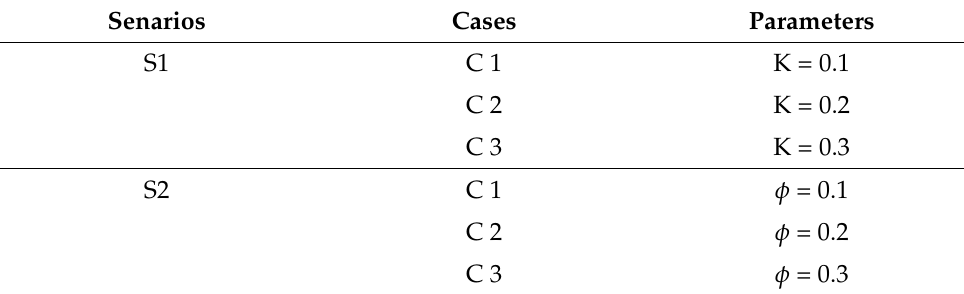
Table 1. All the cases and scenarios discussed in the paper.